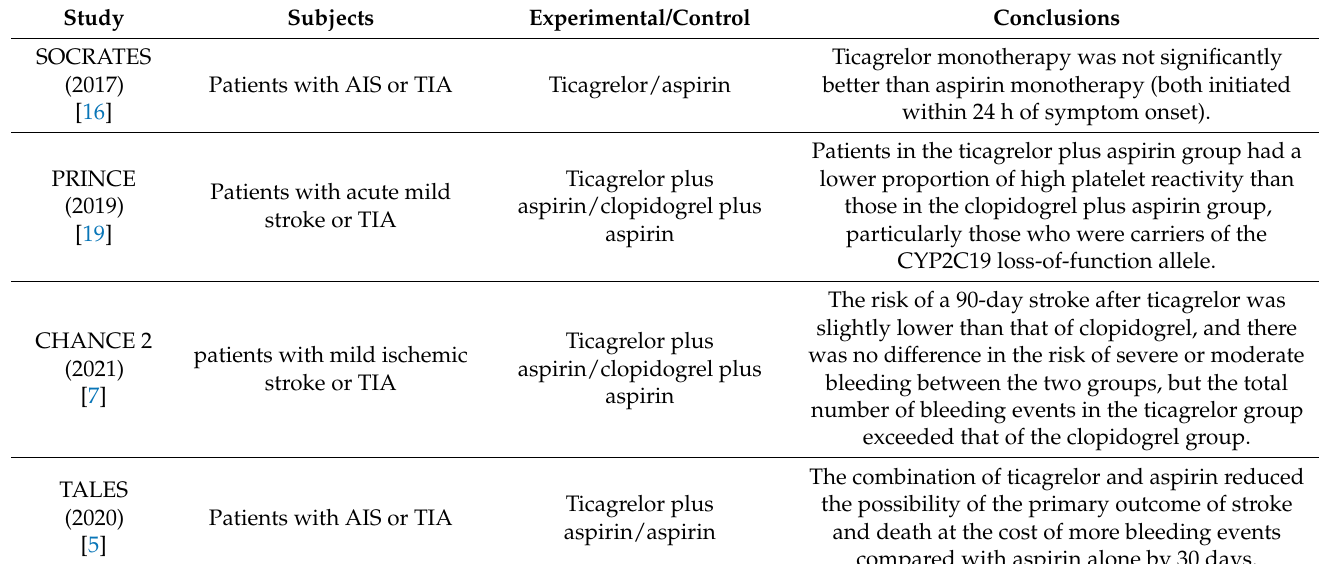
Table 1. Summary of clinical trials that compare the efficiency of ticagrelor with others for